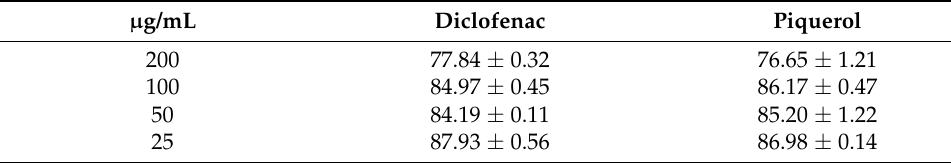
Table 2. Percent human red blood cell membrane stabilization of